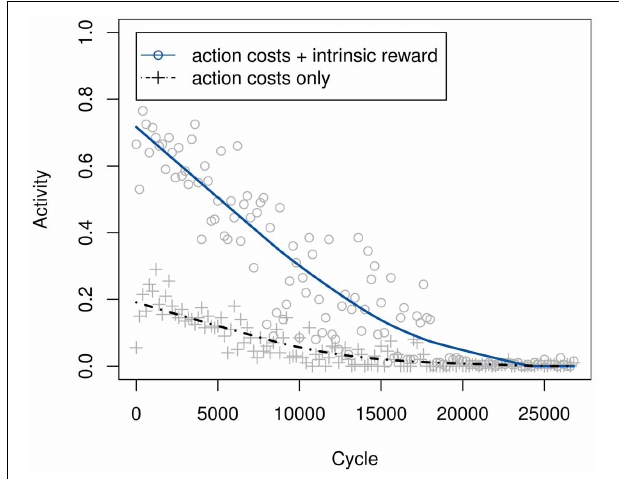
FIGURE 6 | Percentage of non-null actions chosen by the system using both intrinsic and extrinsic rewards, compared to activity using only intrinsic motivation. The goal state is devalued after episodes 50 and 200.